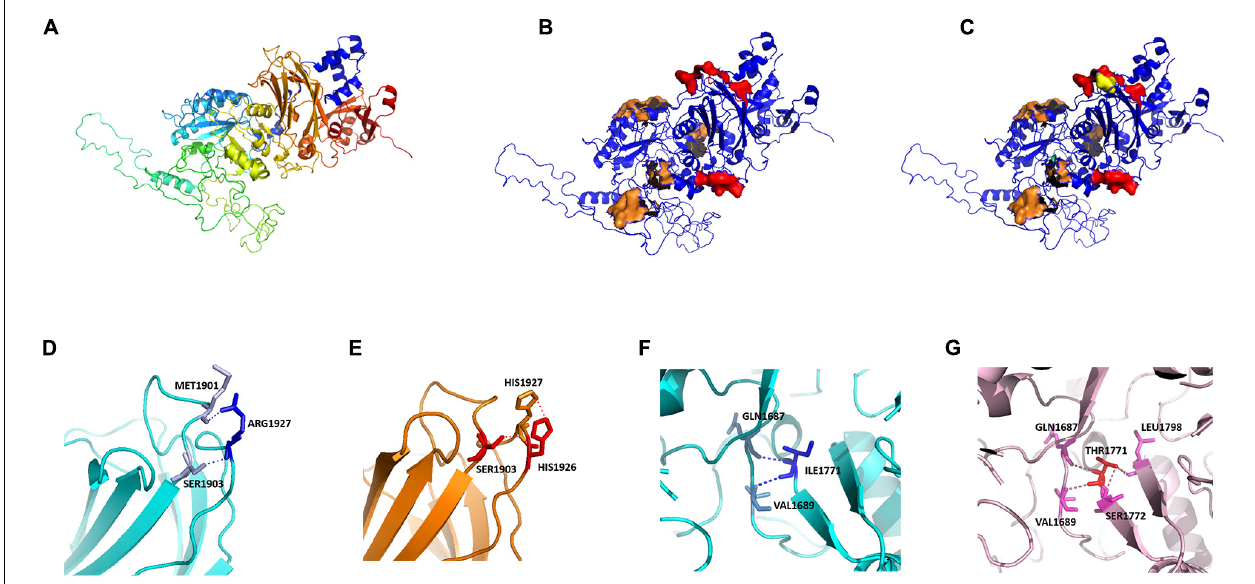
FIGURE 5 | Protein homology modeling of PLCE1 by SWISS-MODEL. (A) The spatial protein model of the original (wild-type) PLCE1. From blue to red showed the coiled peptide chain from N- to C- terminal. (B) Exploration of crucial functional domains of PLCE1. The calcium ion binding pocket was marked in red, and the catalytic binding pocket was in orange. (C) The spatial protein model of the mutant PLCE1 protein. The mutation of rs2274223 (A > G) changed the 1927aa, which may affect the activity of the calcium-binding pocket (yellow). The mutation of rs3765524 (T > C) changed the 1771aa, which may influence the catalytic efficiency of the catalytic binding pocket (green). (D) The wild-type protein microenvironment analysis of PLCE1 on the single 1927aa site. ARG1927 formed two ionic bonds with MET1901 and SER1903, respectively, making the force between the two loops very tight. (E) The microenvironment analysis of the mutation (rs2274223 A > G) of PLCE1. Arg1927His-mutant of PLCE1 formed ionic bonds with these two aa residues; one of them was located on the loop of the 1927 site itself and formed a conjugate bond, making the attraction between the residues stronger than the wild-type. (F) The wild-type protein microenvironment analysis of PLCE1 on the single 1771aa site. Ile1771 formed two ionic bonds with Gln1687 and Val1689 residues, respectively. (G) The microenvironment analysis of the mutation (rs3765524 T > C) of PLCE1. Ile1771Thr mutant formed four ionic bonds with Gln1687, Val1689, Ser1772, and Leu1798, two of which located on the left loop and the others on the right loop, making the local structure more